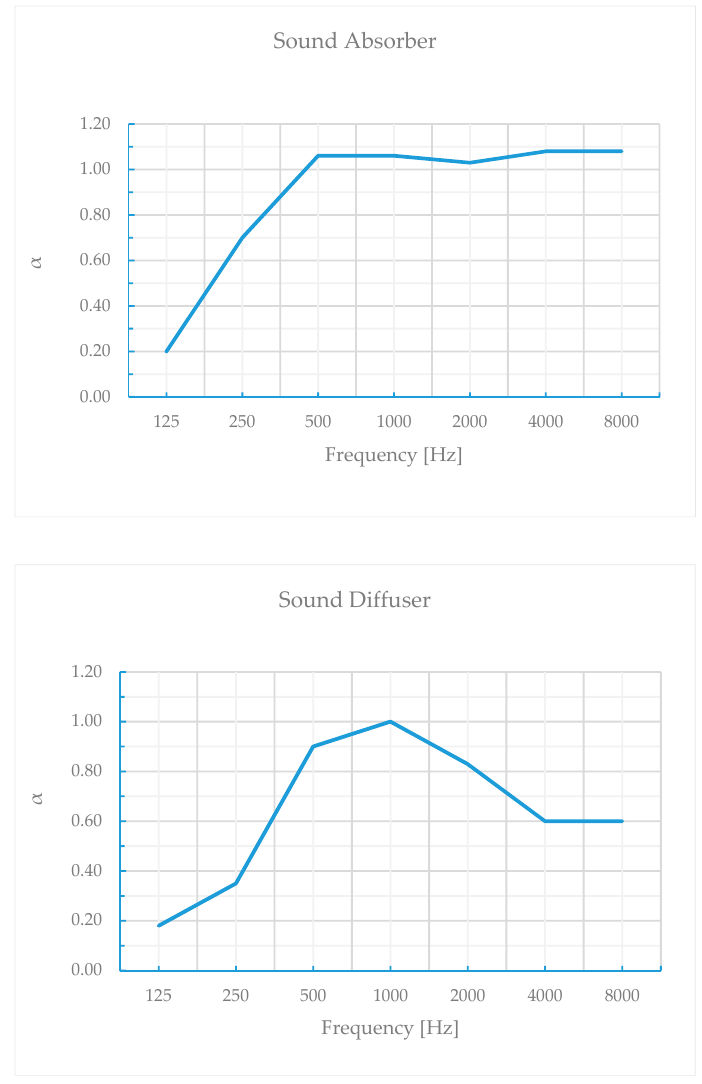
Figure 4. Octave band absorption coefficients of the sound absorptive and sound diffusive panels used for the acoustic treatments in the meeting rooms.